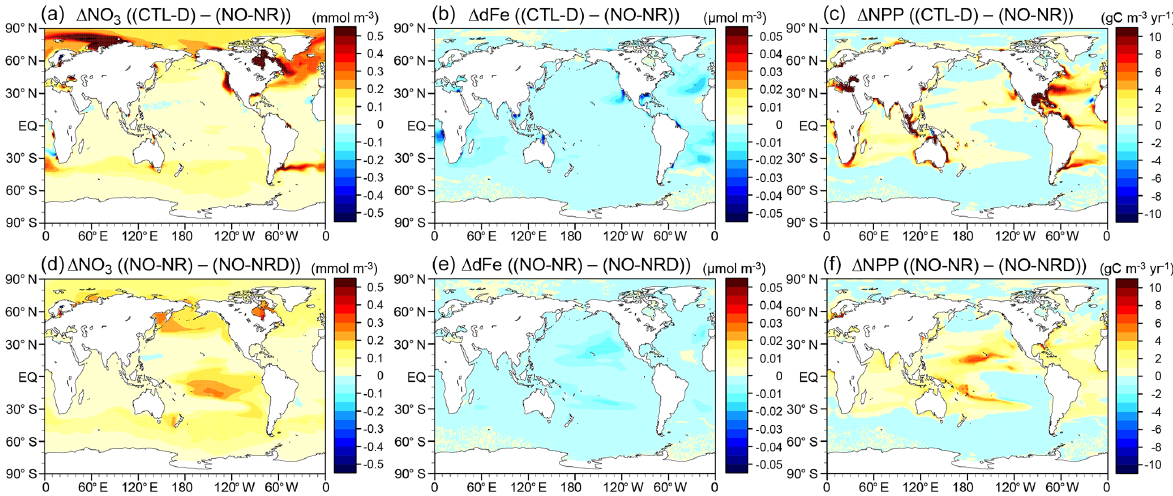
Figure 14. Changes in (a, d) surface nitrate, (b, e) dissolved iron, and (c, f) NPP driven by nitrogen input from (a–c) rivers (CTL-D – NO-NR) and (d–f) atmospheric deposition (NO-NR – NO-NRD).